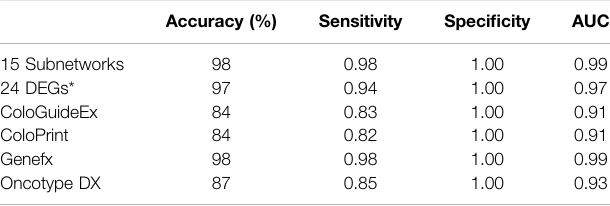
TABLE 2 | Disease classi fi cation results of SVM classi fi ers using 15 subnetwork markers and other known gene signatures. Accuracy (%) Sensitivity Speci fi city AUC